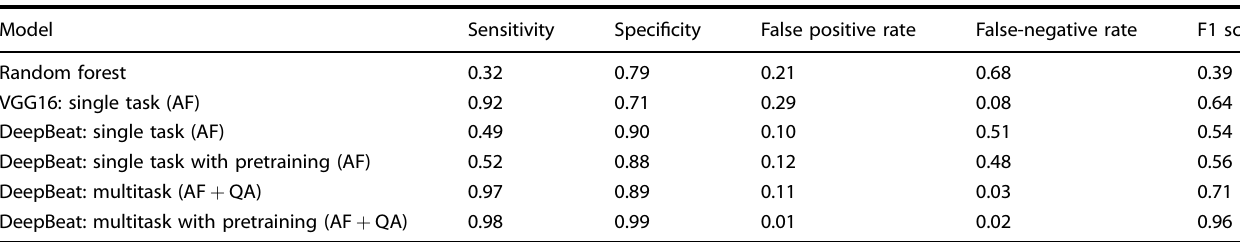
Table 2. Performance of classi fi cation